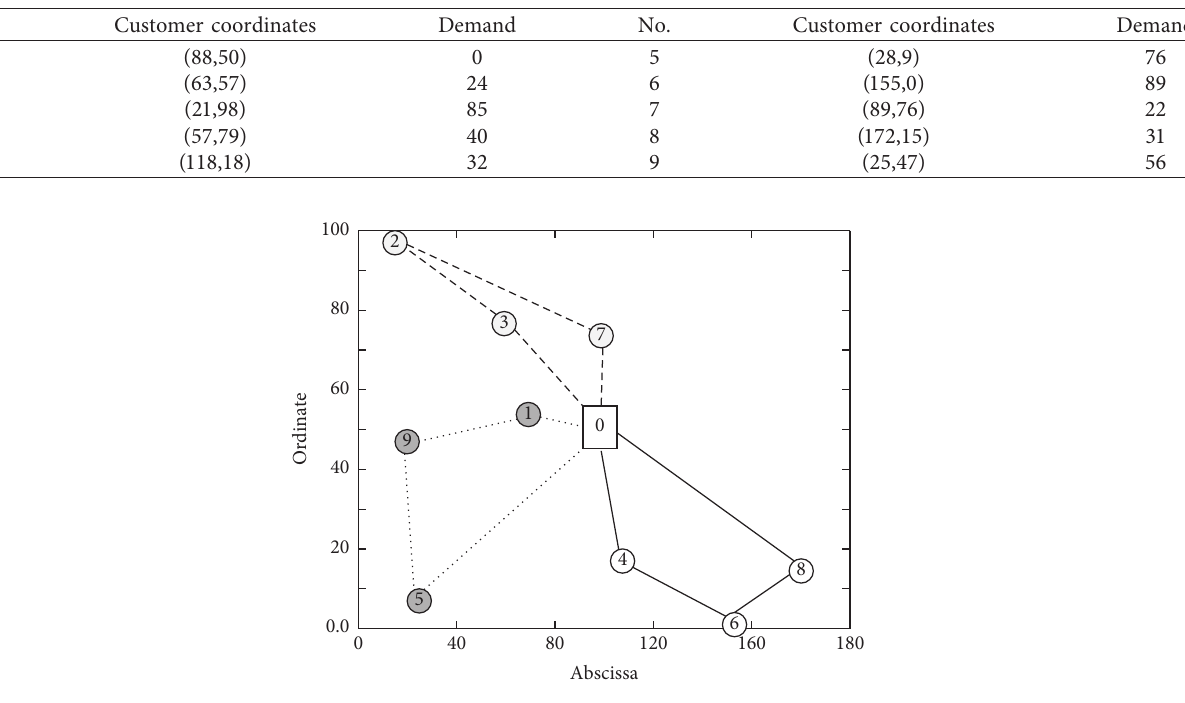
Table 1: Customer information and distribution center.